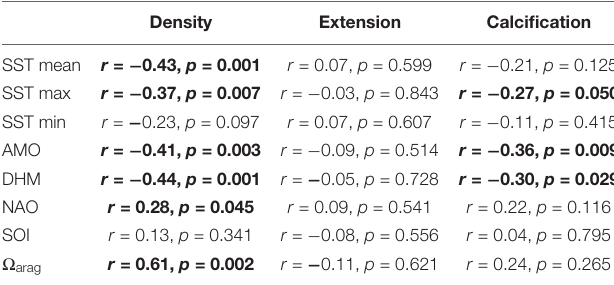
TABLE 2 | Pearson correlations of coral growth parameters with environmental variables during 1963–2015 ( n = 53), and 1988–2011 for (cid:127) arag ( n = 24).